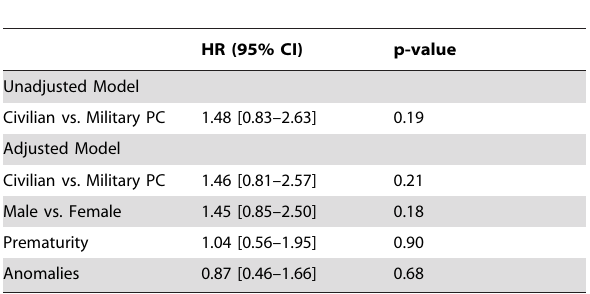
Table 3. Hazard ratios of time to diagnosis of biliary atresia by type of primary care model within the Military Health